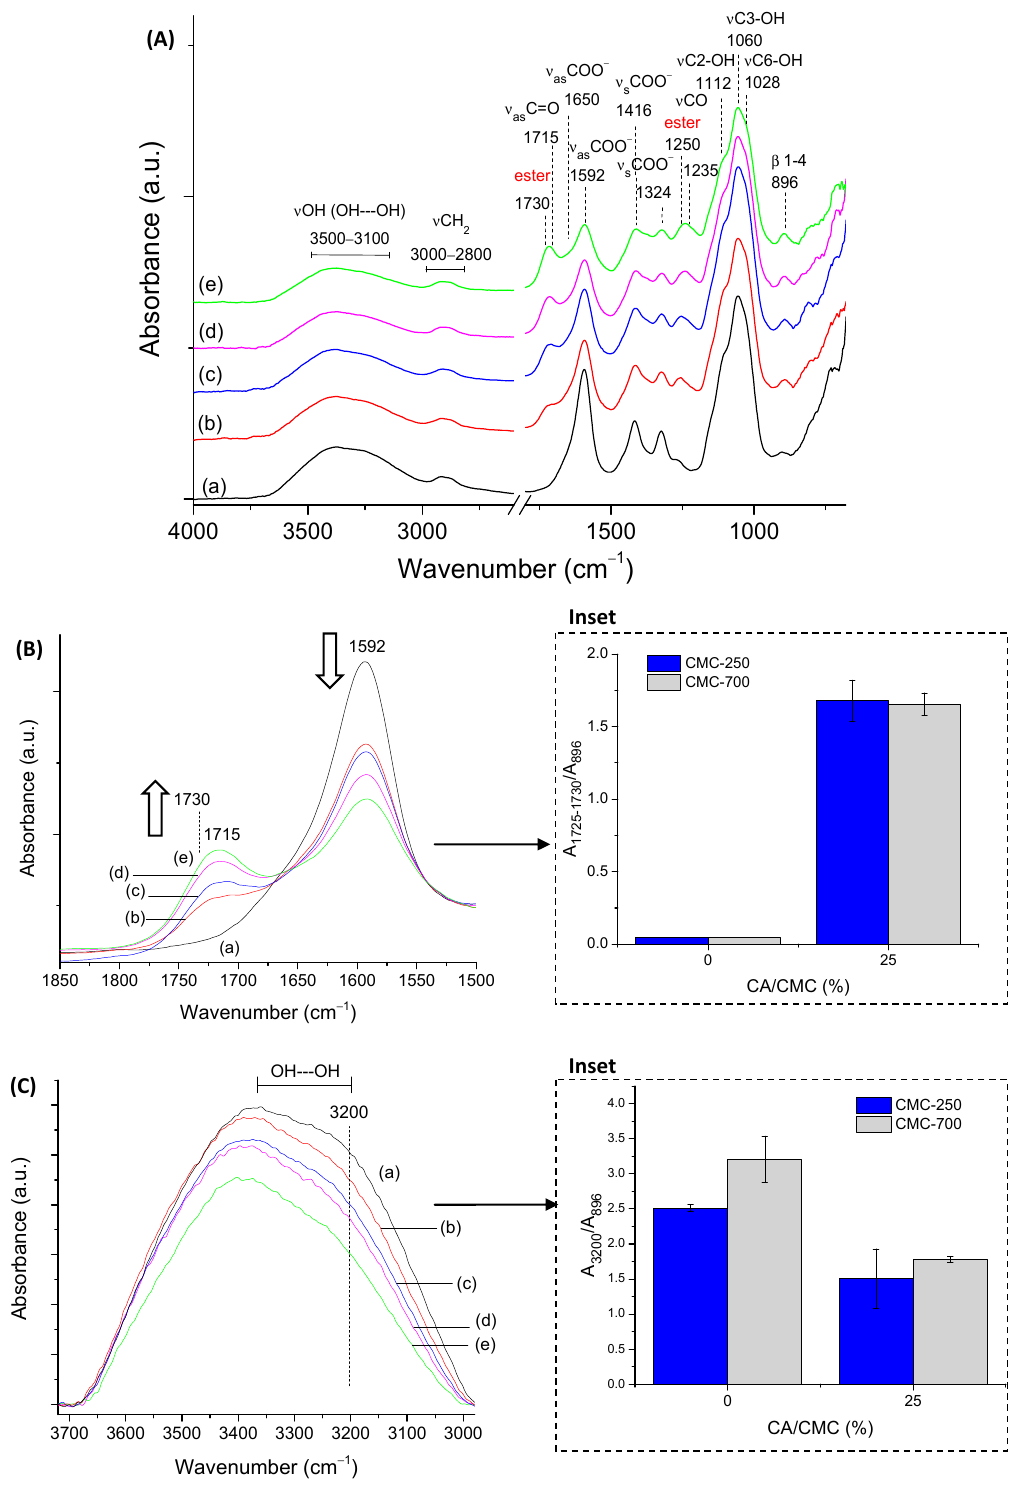
Figure 3. ( A ) FTIR spectra of CMC-250 crosslinked with different amounts of citric acid: ( a ) CA/CMC = 0%, ( b ) CA/CMC = 10%, ( c ) CA/CMC = 15%, ( d ) CA/CMC = 20%, and ( e ) CA/CMC = 25%. Evolution of CMC bands with increasing citric acid content: ( B ) 1850–1500 cm − 1 range associated with ester bonds formation (inset: A 1730 /A 896 ratio; arrows indicate the trend) and ( C ) 3700–3000 cm − 1 range associated with hydrogen bonds’ consumption (inset: A 3200 /A 896 OH interchain band).